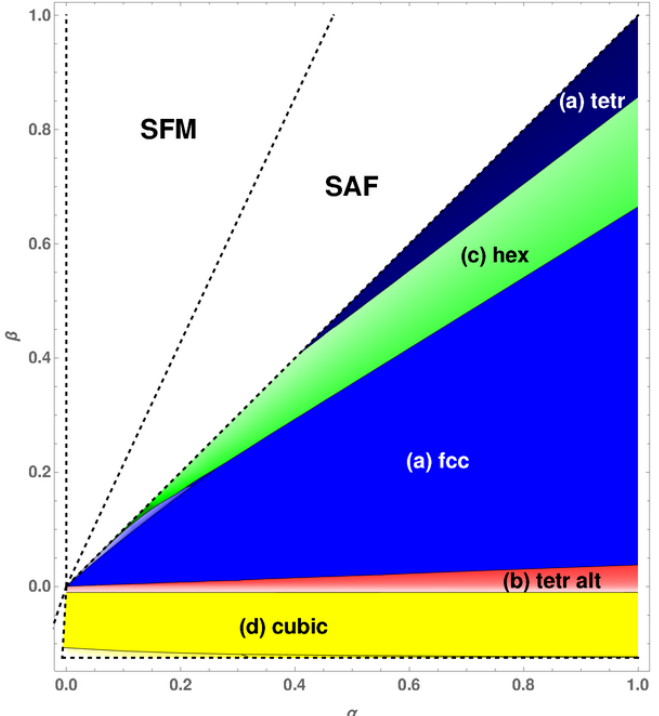
Figure 10: The phase diagram for the non-Abelian crystals. The blue, red, green, and yellow colors indicate crystals (a) , (b) , (c) , and (d) of fig. 9, respectively, as also shown in the labels. Changes in the brightness of the colors indicates changes in aspect